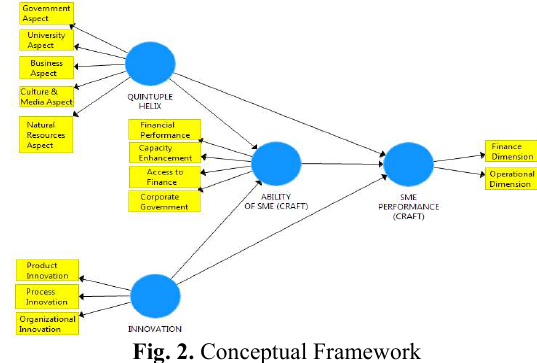
Fig. 2. Conceptual